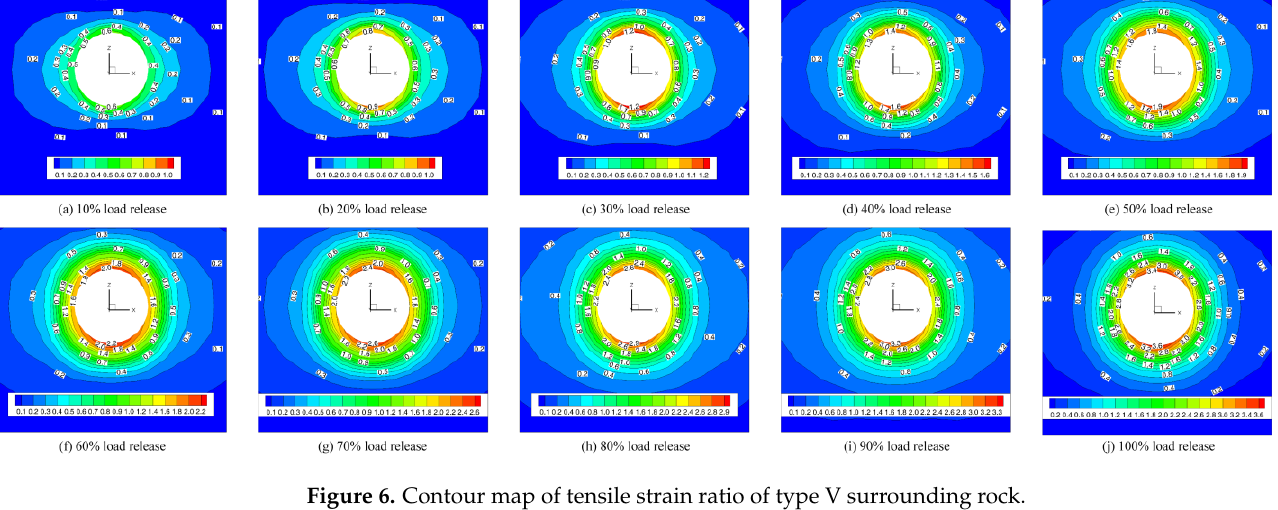
Figure 8. Surrounding rock stress variation with plastic load release coefficient of type V surround- ing rock. 3.